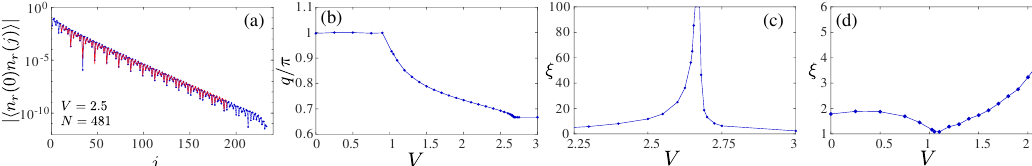
Figure 17: (a) Example of the fitting of the rung-rung correlations to the Ornstein- = 481 rungs, V = 2.5 and U = − 2 V . Blue Zernicke form of Eq.35 for ladder with N r dots are DMRG data, reg line are the result of the four-parameters fit. (b) Wave-vector q as a function of V . (c-d) Correlation length as a function of V has a pronounced peak around the critical point V ≈ 2.67 (c) and a sharp minimum distinct for the disorder line at V ≈ 1